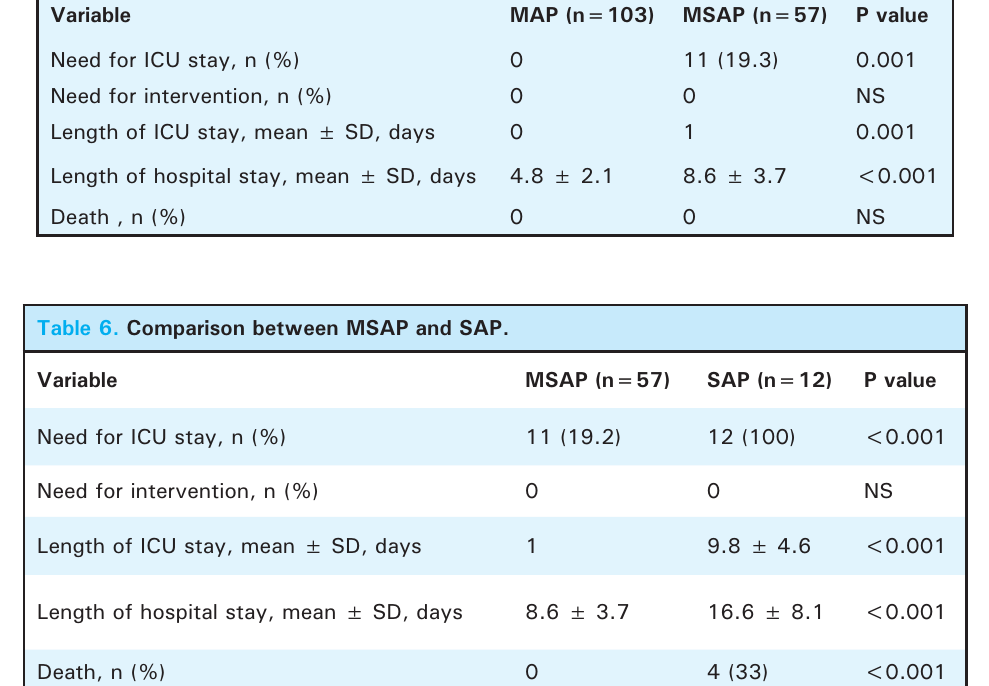
Table 5. Comparison of morbidity between MAP and MSAP.